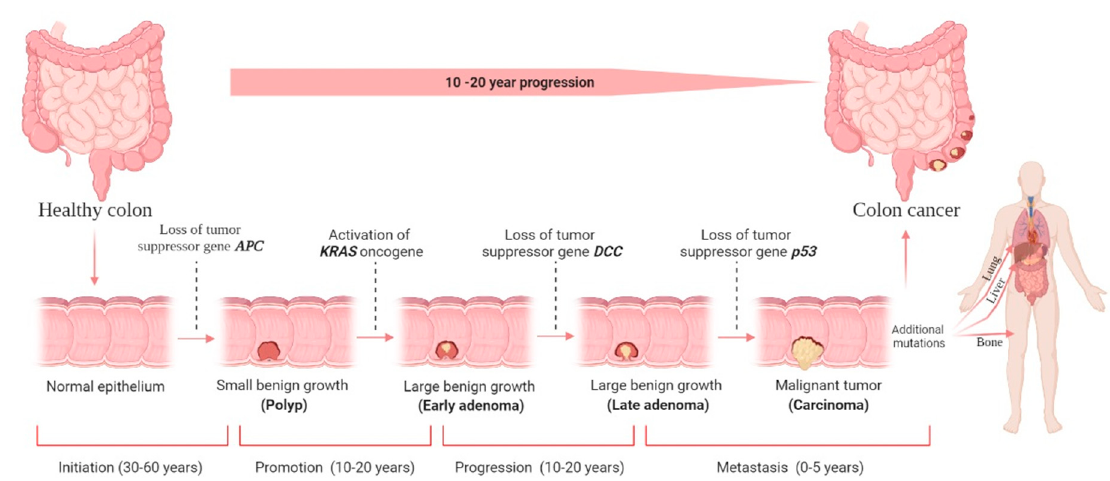
Figure 1. Colorectal cancer (CRC) stages and development. There are four stages in the development of CRC carcinogenesis: initiation, promotion, progression, and metastasis. The liver is the most common metastatic site, followed by the lung and bone. Although it is difficult to determine the duration required for each stage, decades will likely be required to form CRC. The figure was created using BioRender.com (accessed on 30 December 2021).